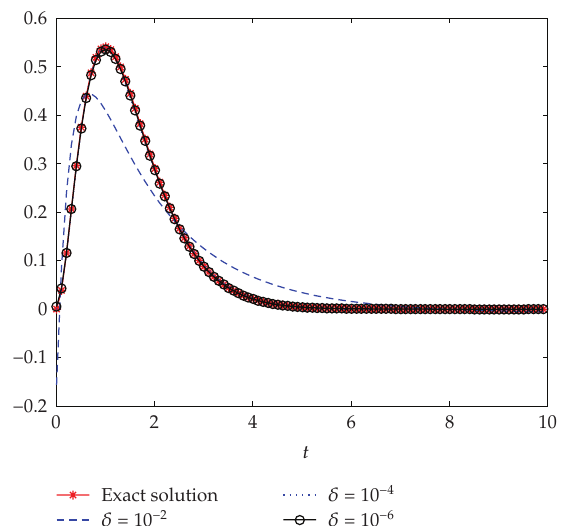
Figure 8: Example 3.8: the stability of the approximate solution.